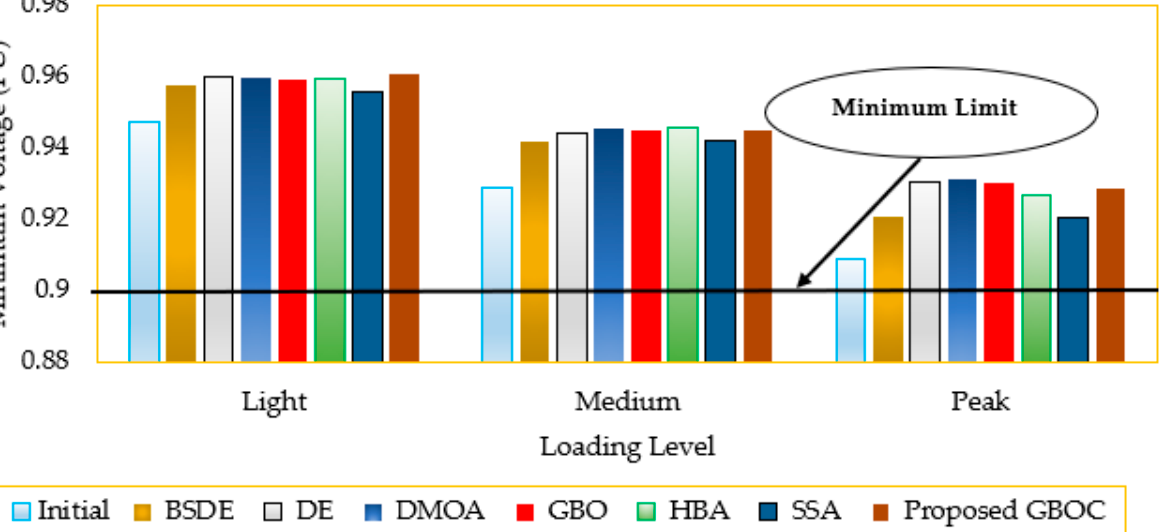
Figure 18. Minimum voltages for the IEEE 69-distribution system of the GBOC versus GBO, SSA, DMOA, DE, and HBA for Scenario 2.